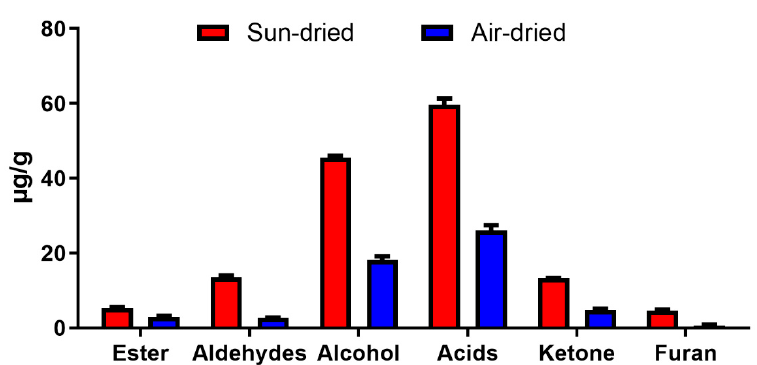
Figure 2. E ff ect of sun- and air-drying methods on the di ff erent classes of fatty acid-derived compounds. Figure 2. Effect of sun- and air-drying methods on the different classes of fatty acid-derived compounds.